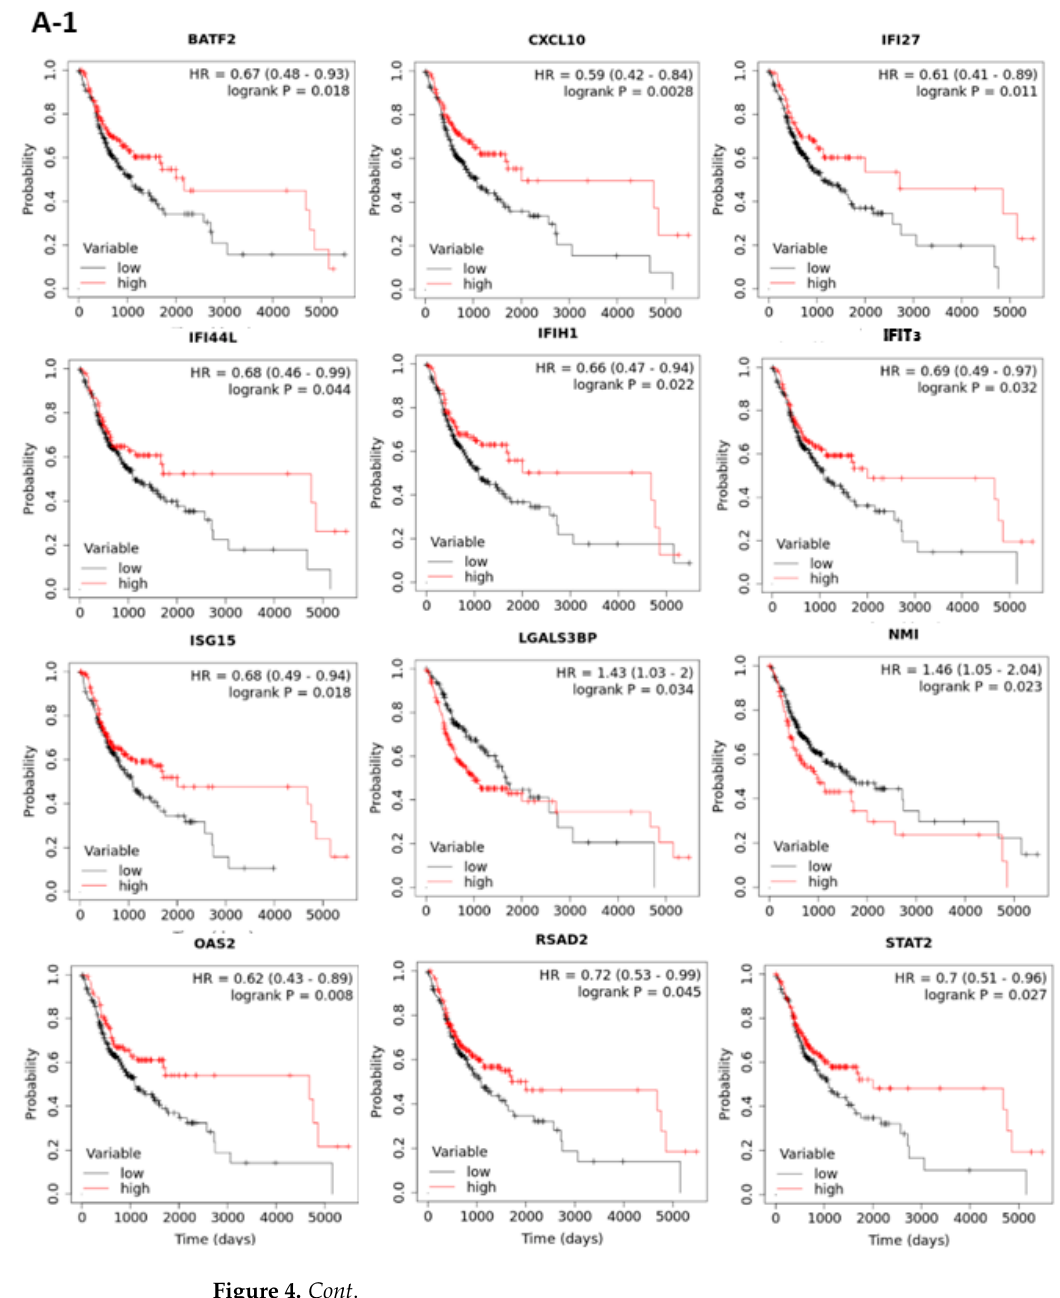
CXCL10 and STAT2 in the following analyses.